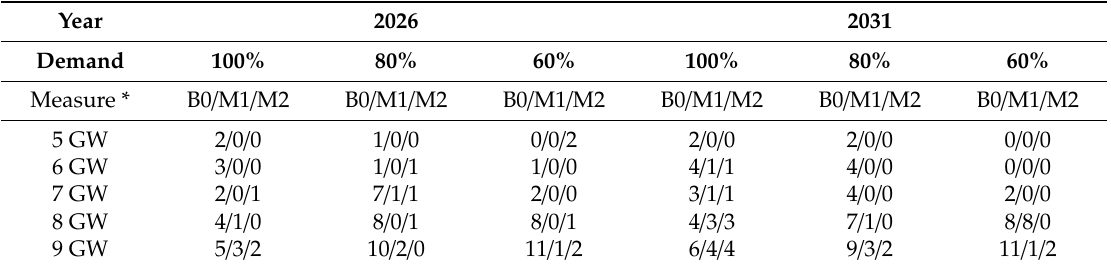
Table 17. Frequency of non-convergence in 2026 and 2031 after reinforcement.